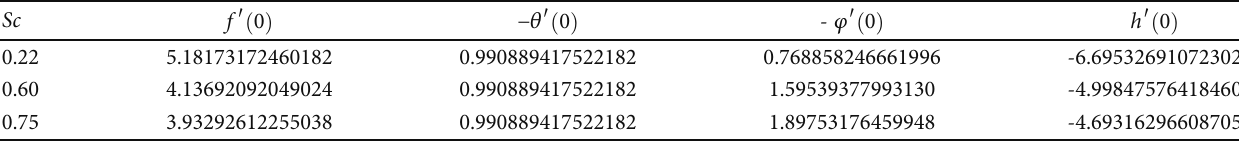
Table 7: Values proportional to the skin friction coe ffi cient, heat transfer and mass transfer for Schmidt number variation with γ = 45 ° ,